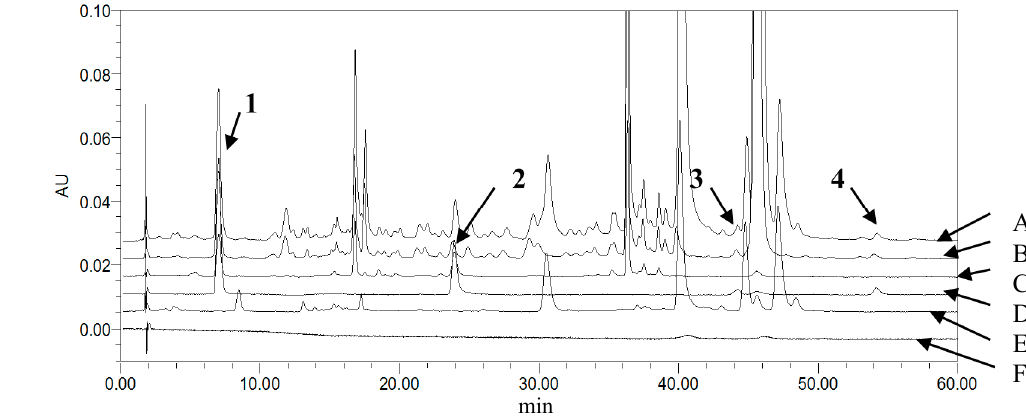
Figure 4. Stacked view of HPLC chromatograms (wavelength: 270 nm) of (A) GZFLW; (B) Moutan cortex; (C) Paeoniae radix alba; (D) mixed reference standards; (E) negative control; (F) Blank solvent (from up to down).